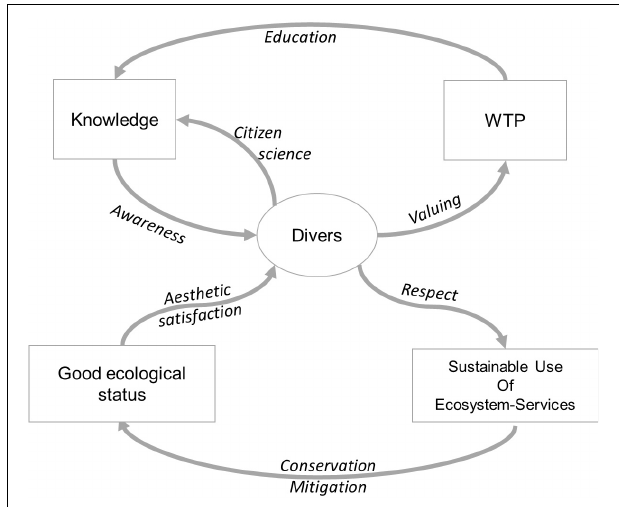
FIGURE 4 | Ocean and Ecological literacy can promote the sustainable use of marine ecosystems and contribute to both ecological conservation and blue growth. In fact, even if divers value (and are willing to pay for) pristine and well-preserved ecosystems mainly for aesthetic reasons, they appreciate, respect, and value them even more, when they are aware of the ecological importance of those systems. Positive feedback arises when extra-value is used to sustain education, conservation and